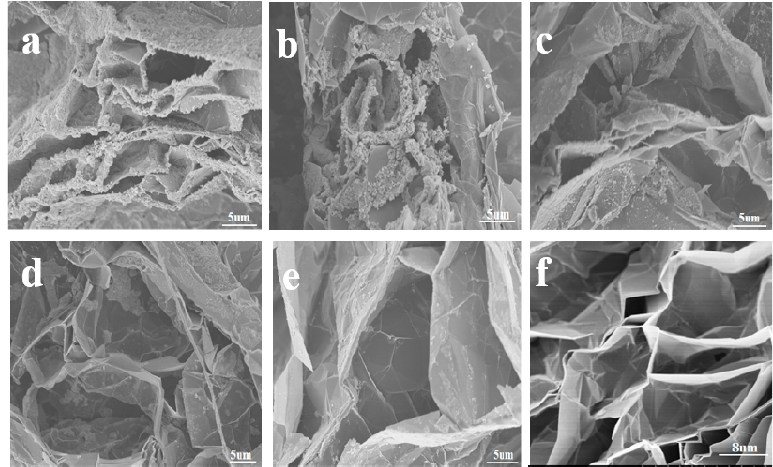
Figure 2. Scanning electron microscopy (SEM) images of expanded graphite (EG)/Fe 3 O 4 prepared from different concentrations of Fe 3 O 4 (gradually decreased from a – e in the figure) and EG ( f ), respectively.